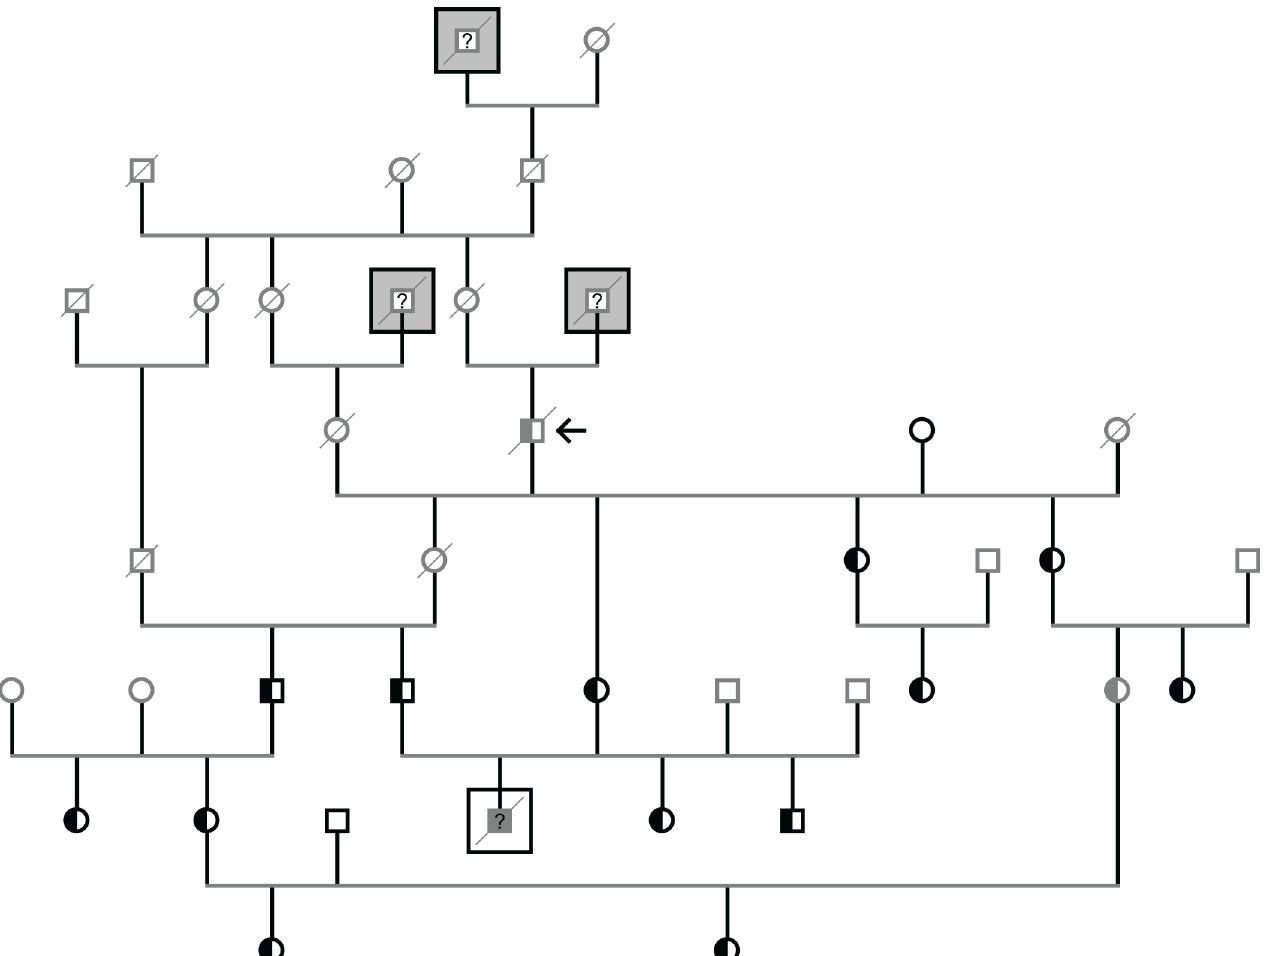
Fig 3. Inheritance of cerebellar ataxia in a pedigree of Norrbottenspitzes. All Norrbottenspitzes identified as carrying the Finnish Hound ataxia mutation ( SEL1L c.1972T > C) can be traced back to the oldest obligate carrier dog (marked with an arrow symbol). Three dogs of unconfirmed background (squared on gray background) registered into the breed represent potential events of introduction of the mutation into the Norrbottenspitz populaation. A puppy (squared on white background) euthanized due to neurological symptoms matching the expected disease phenotype was born from a mating between two carrier dogs. Gender symbols of dogs with unconfirmed genotypes are shaded gray.